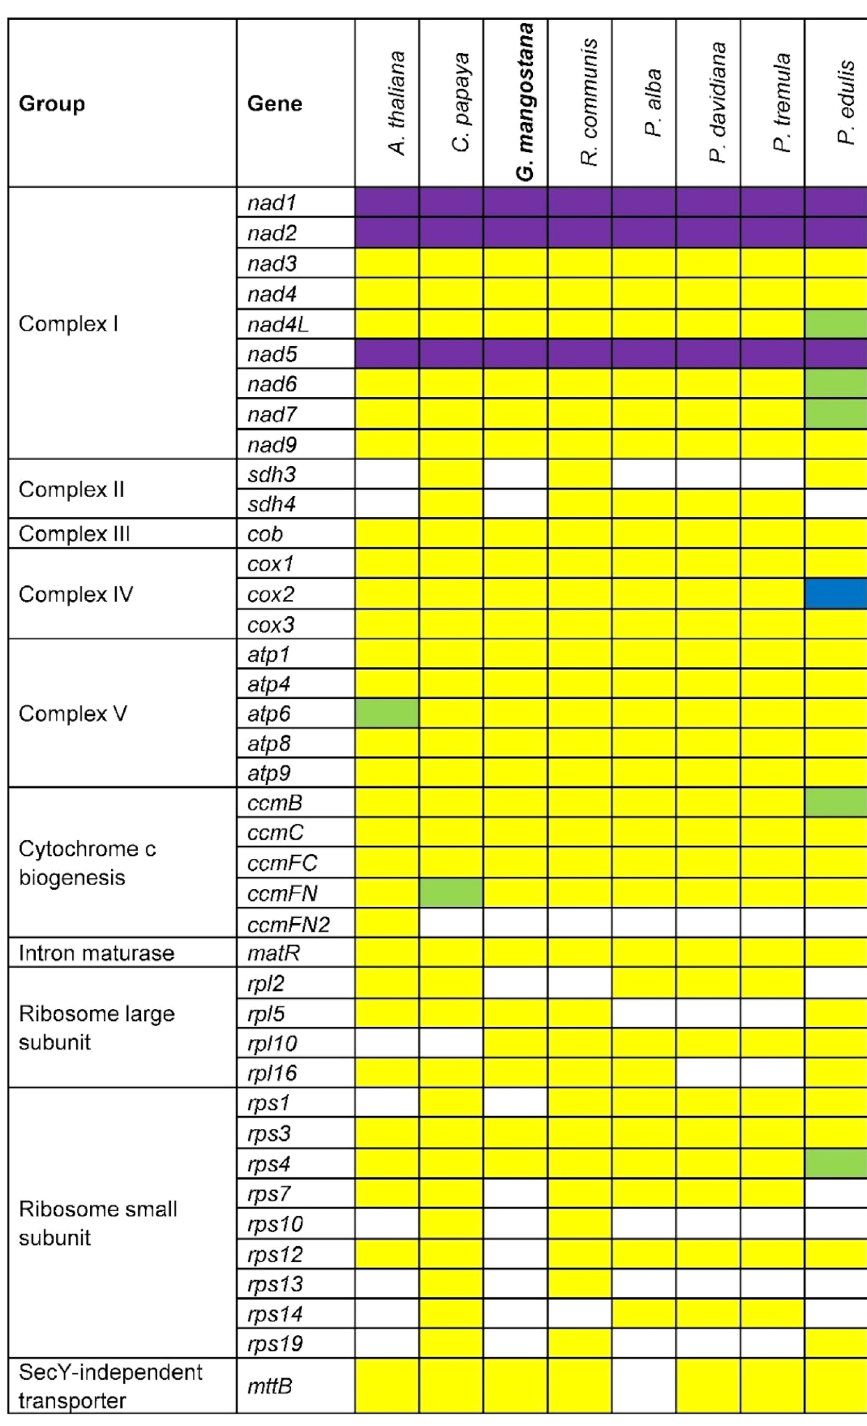
Figure 2. Protein-coding genes in plant mitogenomes. White boxes indicate that the gene is not present in the mitogenome. Yellow, green, and blue boxes indicate that one, two, and four copies exist in the mitogenome, respectively. Purple boxes indicate trans-splicing. Mangosteen ( Garcinia mangostana ) is shown in